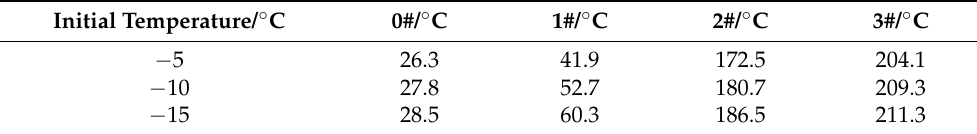
Table 4. Highest temperature of UMLs with different SiC particle